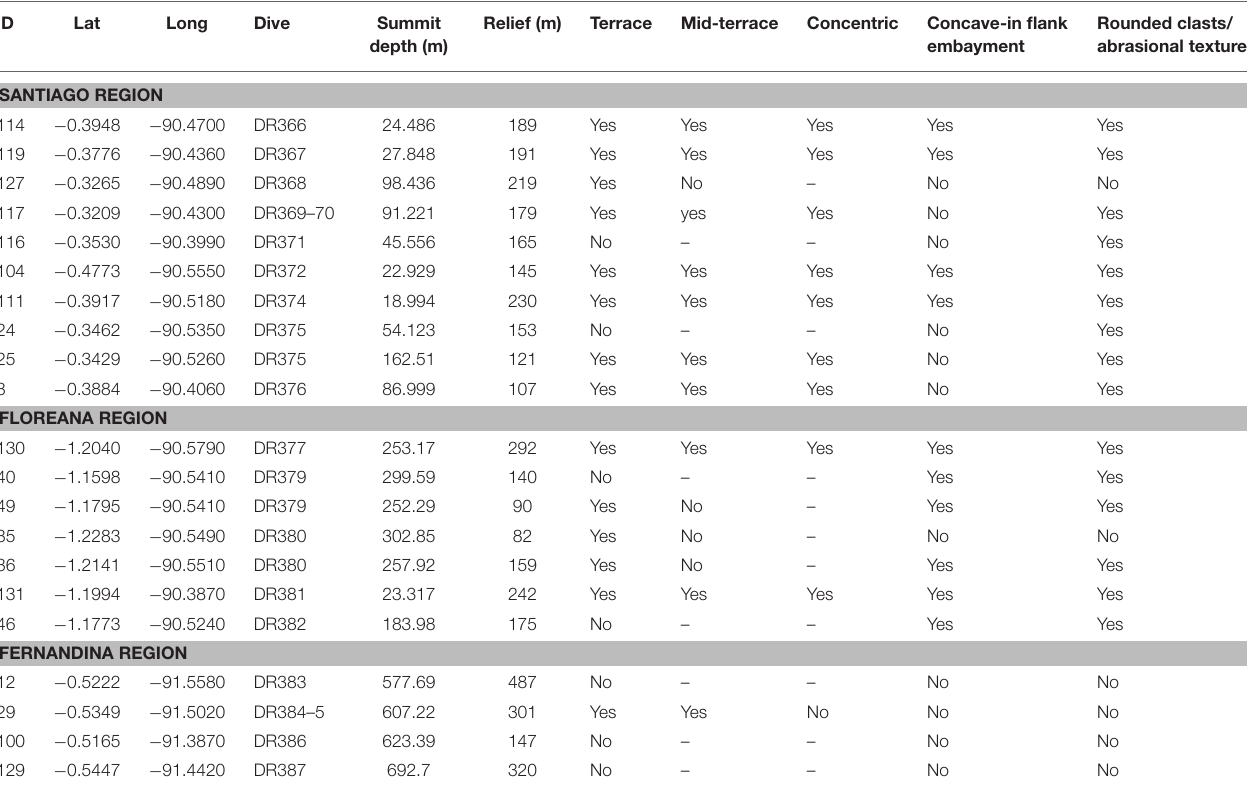
TABLE 1 | Table of seamounts visited by HOV relating direct seafloor observations to bathymetric